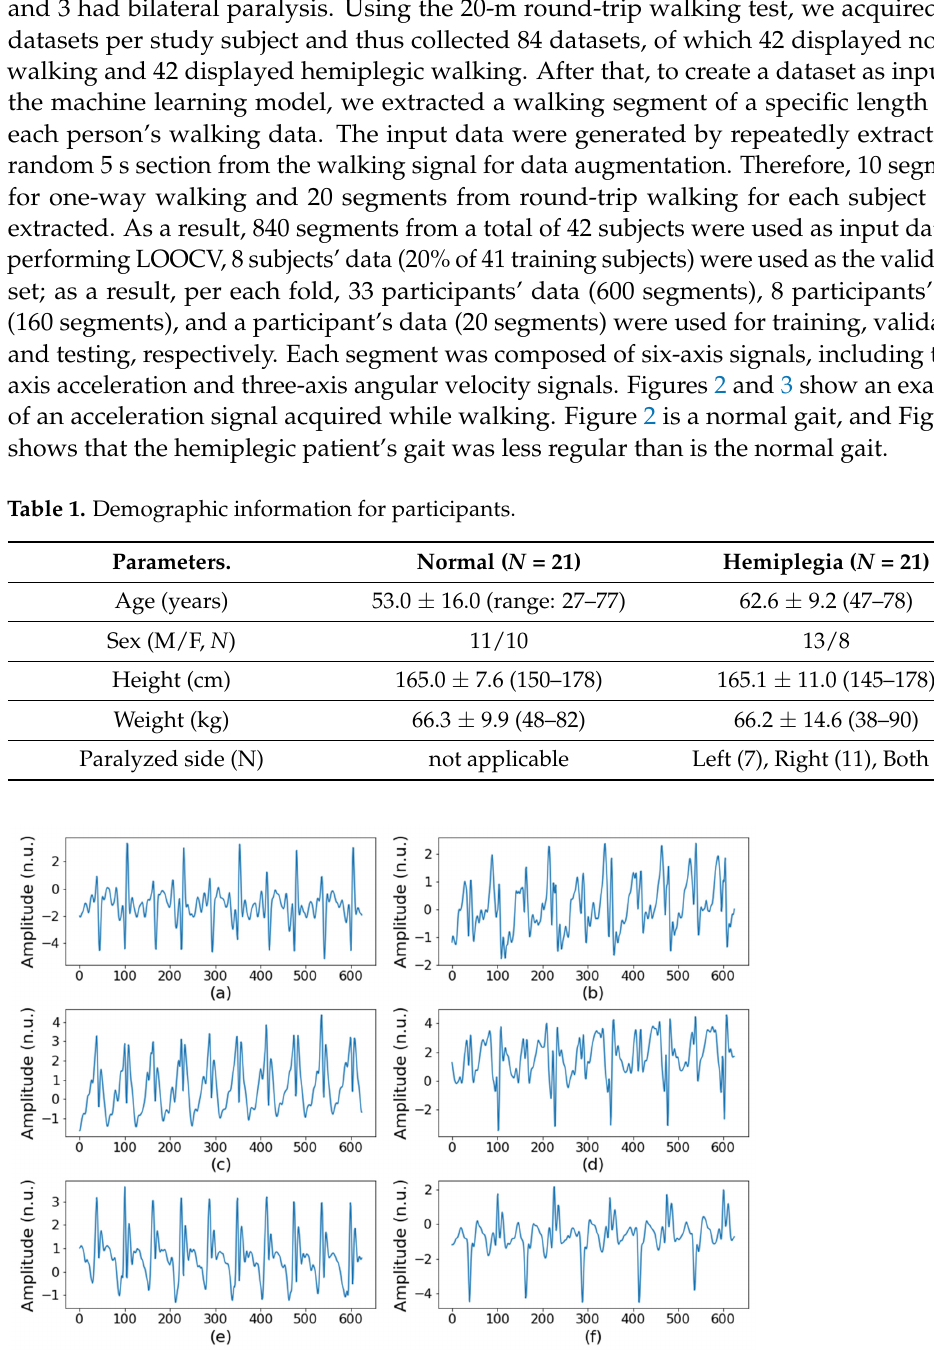
Figure 2. Inertial signals of normal gait: ( a ) acceleration in the x axis, ( b ) angular velocity in the x axis, ( c ) acceleration in the y axis, ( d ) angular velocity in the y axis, ( e ) acceleration in the z axis, and ( f ) angular velocity in the z axis.